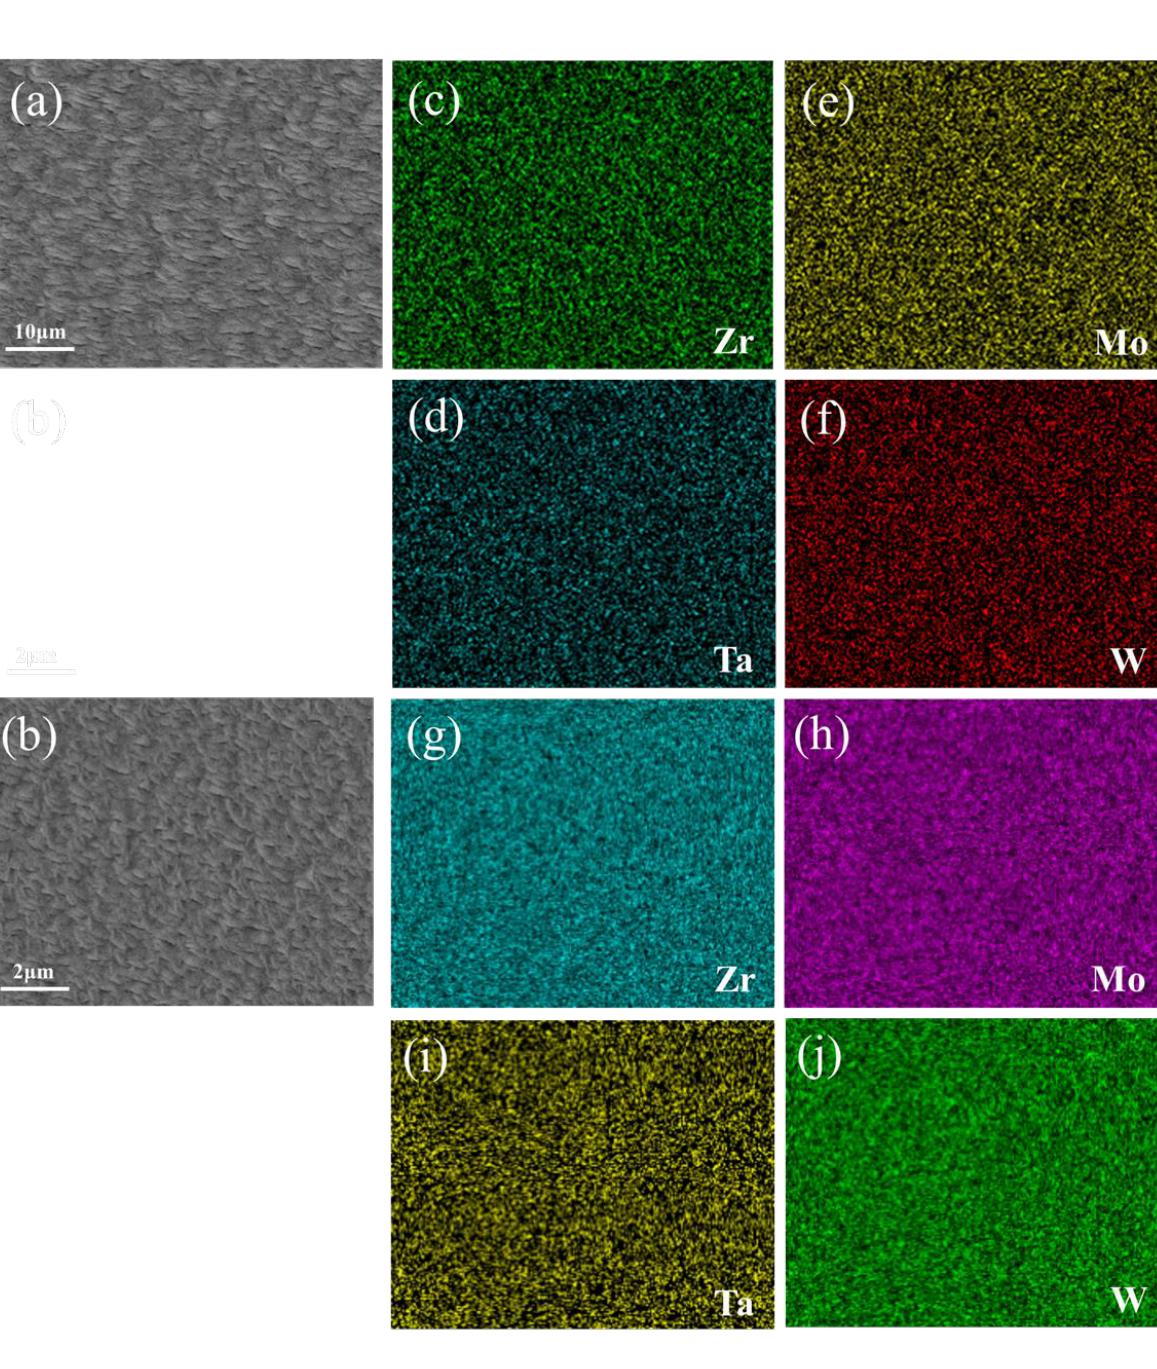
Figure 4. ( a , b ) SEM images of surface morphology of F6C and D11 thin film and ( c – j ) EDS elemental maps of region shown in ( a , b ).